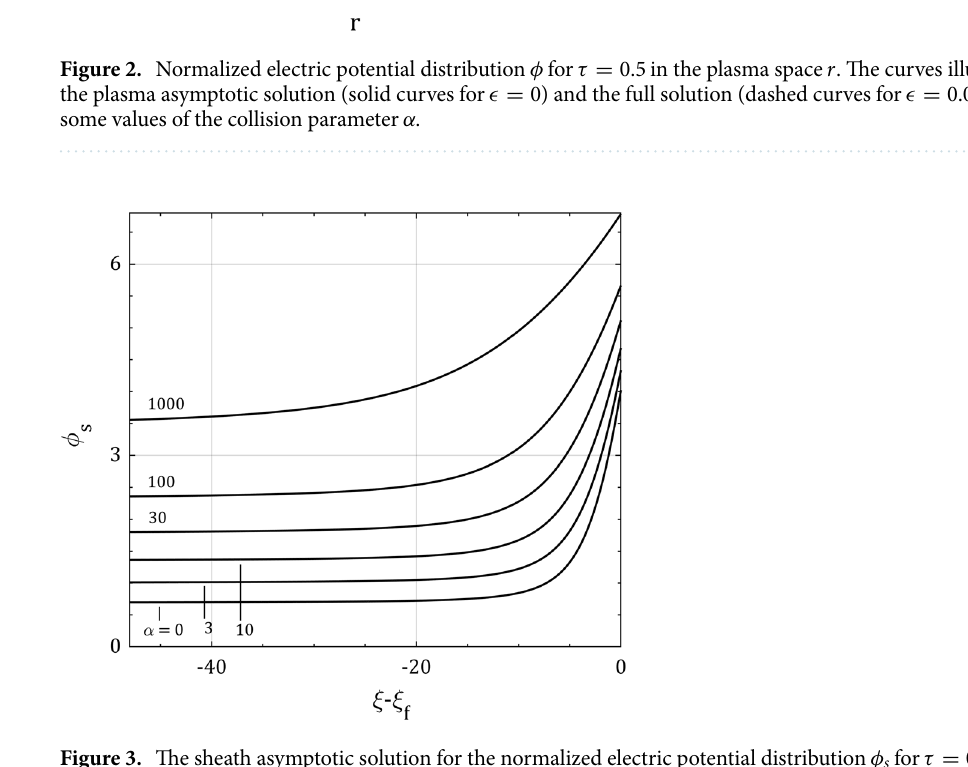
Figure 3. The sheath asymptotic solution for the normalized electric potential distribution φ s for τ the sheath space ξ . Note how the floating potential φ f and the potential at the plasma-sheath border φ b grow up when the collision parameter α Figure 4 represents the plasma asymptotic and full solutions of the normalized electrical potential distribu- 10 and different values of τ , in which the general form of the electrical potential variations in the tion for α = both solutions is as in Fig. 2. It is seen that general effect of ion temperature τ is to enlarge the plasma boundary layer extension and to decrease the normalized floating potential φ f . Similar results can be seen in some recent works on the warm plasma with low ion temperature using approximate methods 27,28,39 .